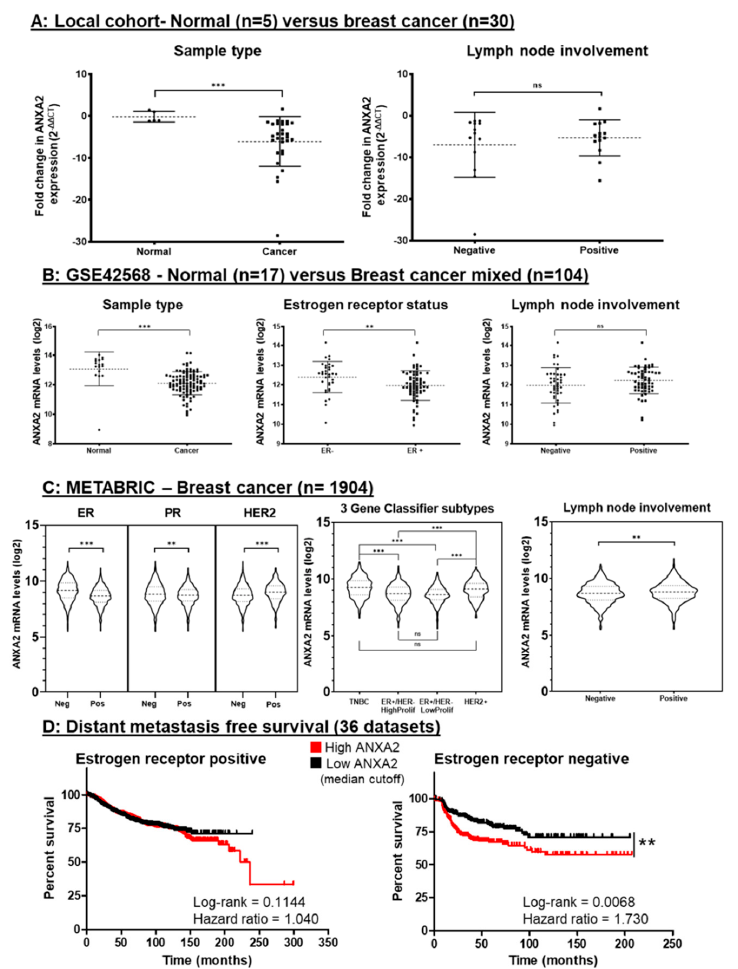
Figure 5. ANXA2 expression is associated with and is a prognostic indicator in ER negative breast cancer. ( A ) Analysis of ANXA2 expression using qRT-PCR of normal ( n = 5) and breast cancer ( n = 30) tissue samples. Analysis showed ANXA2 is significantly upregulated in normal tissue versus cancer tissue ( p = 0.0002). Gene expression represented as fold change from normal closest to mean. Horizontal bars represent the mean and SD of fold change. Statistical di ff erence between groups tested using Mann Whitney U test. ( B ) Analysis of ANXA2 mRNA expression in GSE42568 showing ANXA2 is upregulated in normal tissue versus cancer tissue, ( p < 0.0001), in ER- breast cancer versus ER + breast cancer ( p = 0.0094) and in patients with nodal positive disease ( p = 0.1121). Horizontal bars represent the mean and SD gene expression levels. Statistical di ff erence between groups was measured using Student’s t-test. ( C ) Analysis of ANXA2 mRNA expression of the METABRIC cohort showing upregulation of ANXA2 in ER negative ( p < 0.0001), PR positive ( p = 0.0013) HER2 positive ( p < 0.0001) and in nodal positive ( p = 0.0050) breast cancer patients. Using the 3 gene classifier (42) to stratify patients shows TNBC and HER2 + subtypes to have significantly higher expression of ANXA2 than both ER +/ HER2- subtypes. Statistical di ff erence between groups was calculated using Mann–Whitney U test. ( D ) Kaplan–Meier curves comparing the DMFS of patients with high ANXA2 expression (red) versus low ANXA2 expression (black) as determined by median expression value cut-o ff . Curves were analyzed using univariate log-rank tests. Expression of ANXA2 was found to not have a significant e ff ect in ER + patients whereas it did significantly increase probability of distant metastasis for ER- patients ( p =